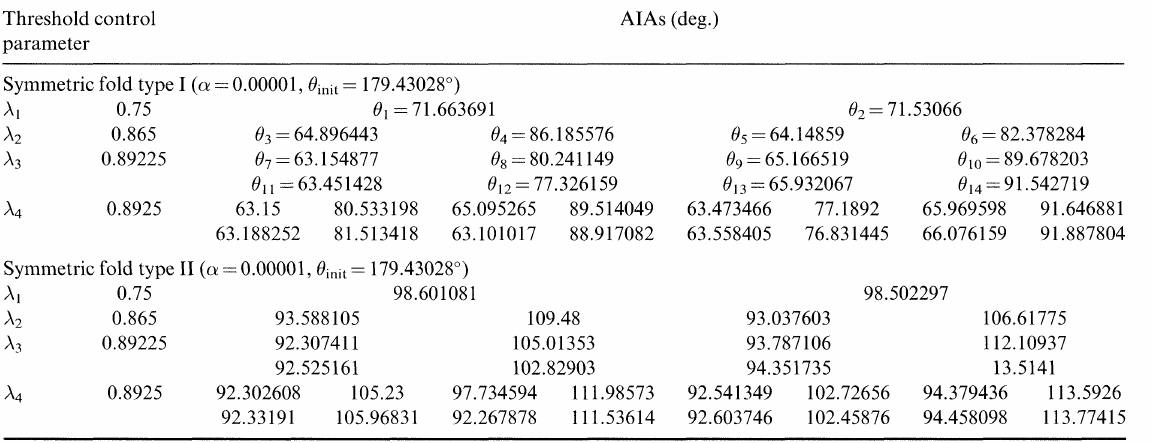
TABLE III AIAs at the threshold regulatory forces after 3 x 104 time steps: The dynamical rule is simple first order nonlinear difference equation with constant stress control parameter Threshold